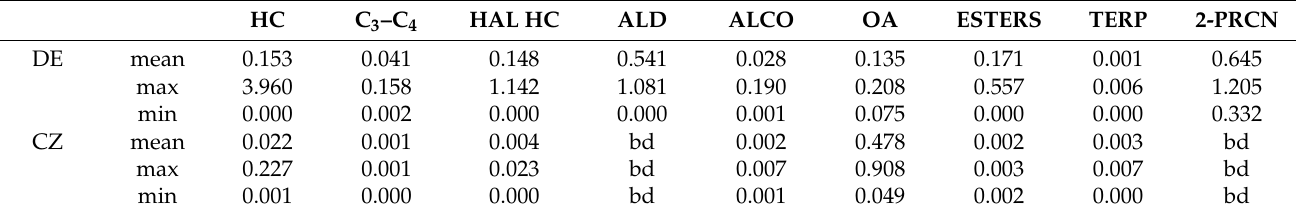
Table 7. Hazard Index (HI) for chronic, non-carcinogenic effects from exposure to VOCs during odor episodes in the vicinity of the German–Czech